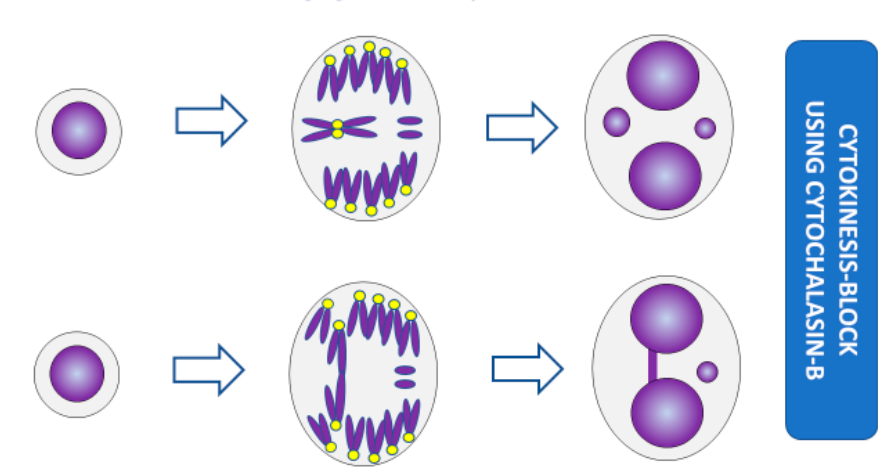
Figure 2. Formation of micronuclei and nucleoplasmic bridges in cytokinesis-blocked cells. (For the sake of simplicity, the conceptual diagrams only show a representative fraction of chromosomes.) Yellow dots represent centromeres. The acentric fragments in the bottom panel are generated during mis-repair of DNA strand breaks but not during incomplete chromatid separation or telomere end- fusion.